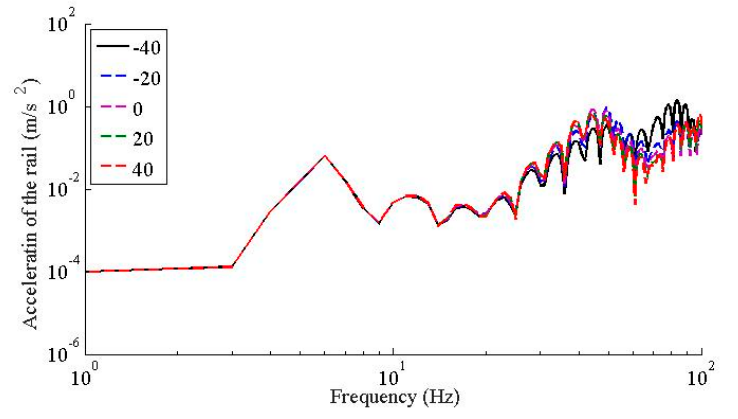
Figure 12. Vertical acceleration of the rail under − 40, − 20, 0, 20, and 40 °C.